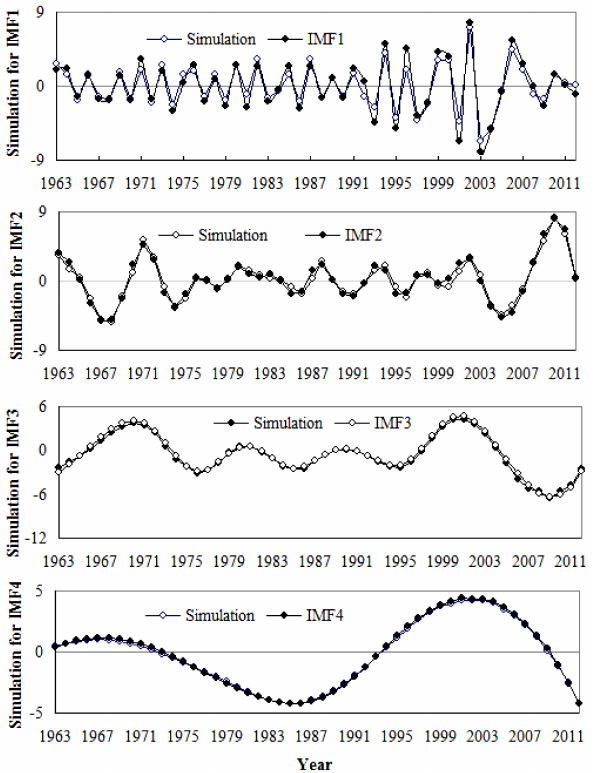
Figure 10. Simulation for the IMFS of AR by BPANN.